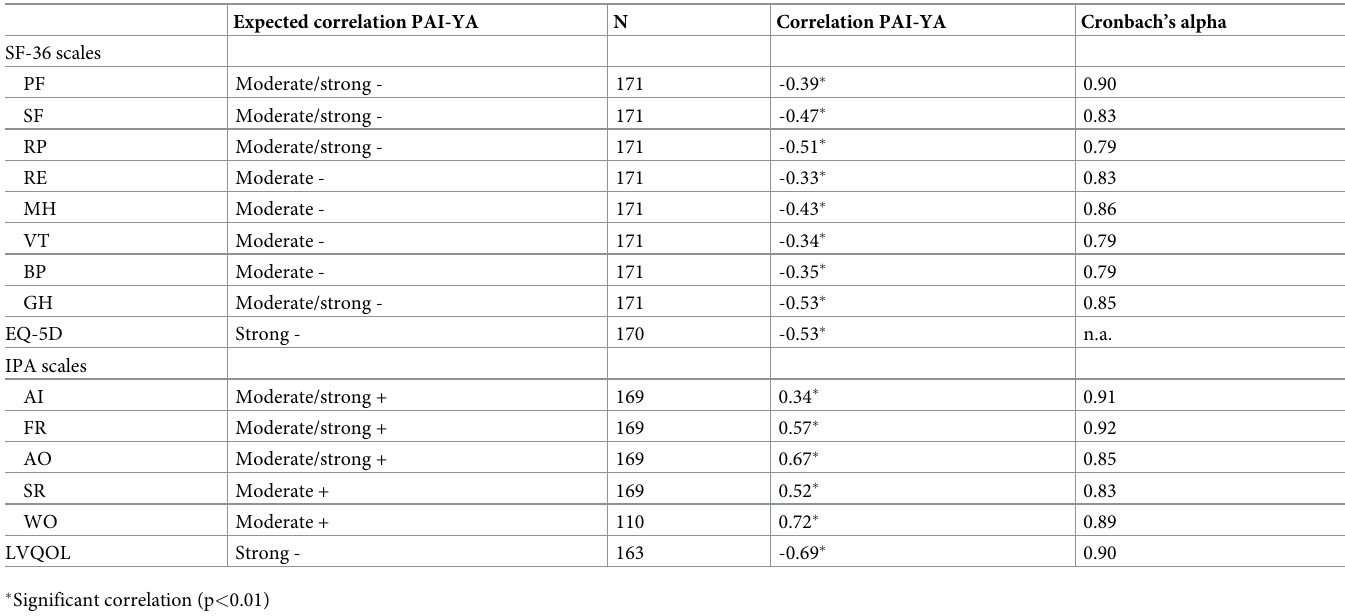
Table 4. Correlation coefficients of the PAI-YA with (scales of) other